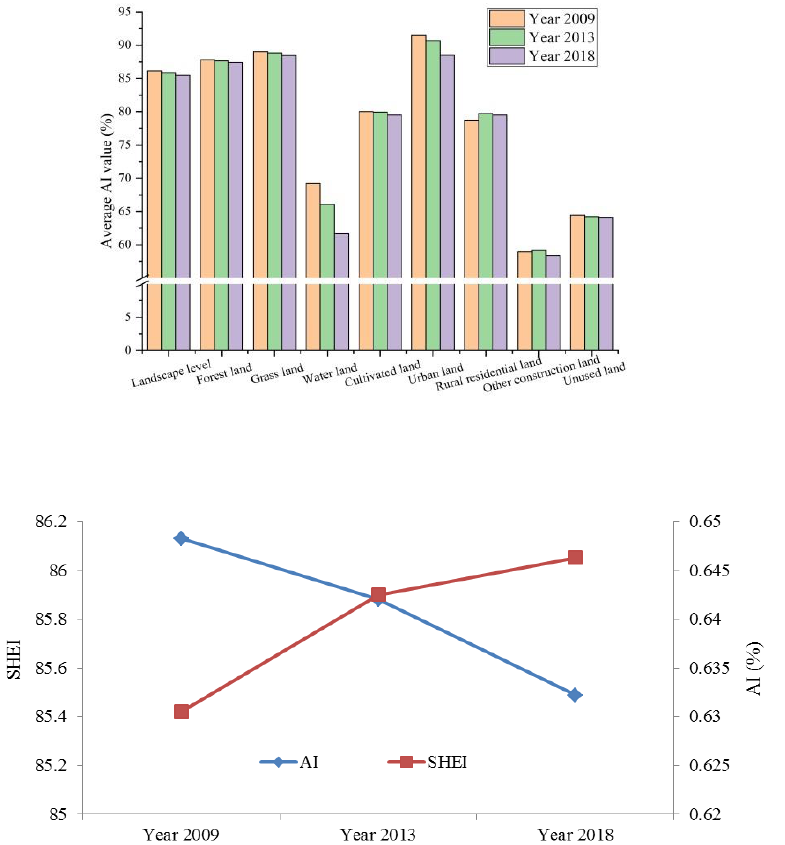
Figure 7. Change in landscape diversity in Yujiang District from 2009 to 2018.